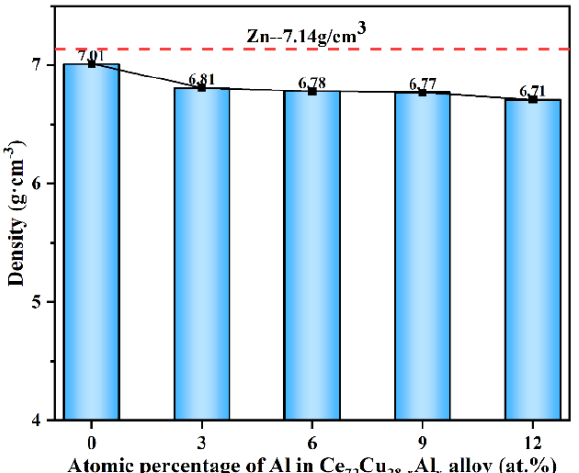
Figure 6. Density variation of Ce 72 Cu 28-x Al x alloys with the change in Al contents.